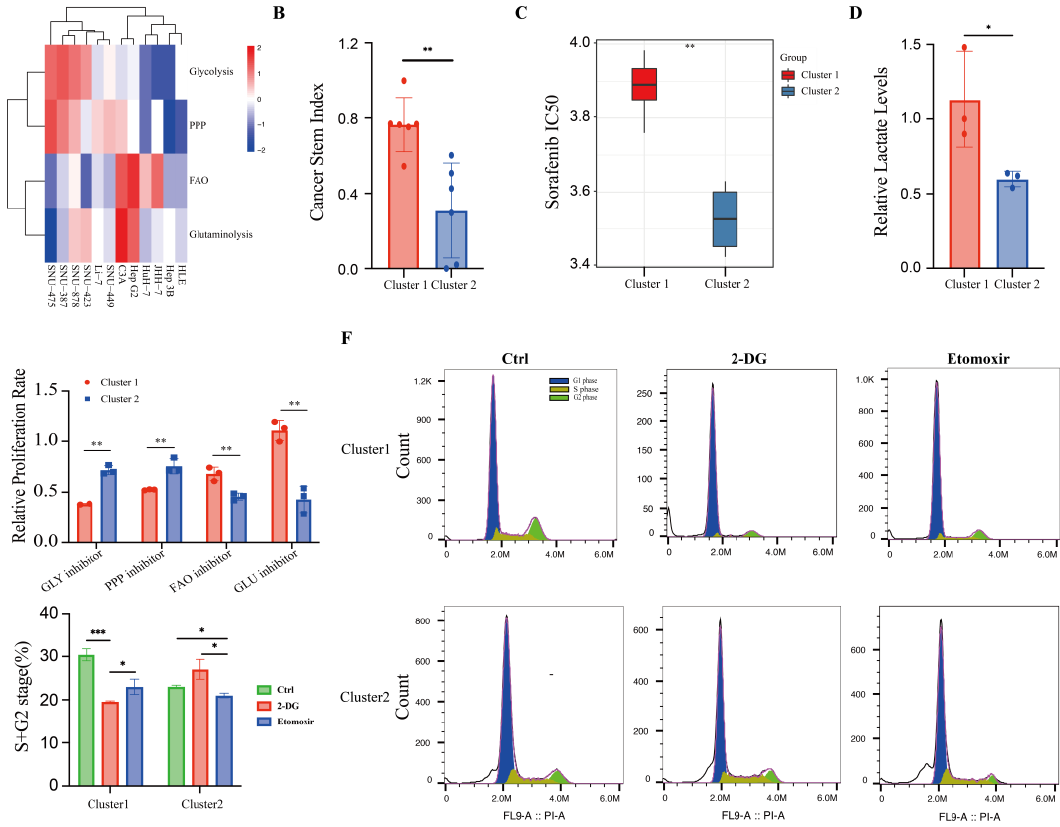
Figure 5. Liver cancer cell lines revealing potential metabolic therapy targets. ( A ) A heatmap showing the metabolic pathway activity levels of 12 common liver cancer cell lines from CCLE. ( B ) Cancer stem indexes of two clusters of liver cancer cells. ( C ) Boxplots of estimated IC50 values for sorafenib. ( D ) Relative lactate production of liver cancer cells. ( E ) Relative proliferation rate upon four metabolic perturbations in HCC cell lines. ( F , G ) Cell cycle progression upon two metabolic perturbations in HCC cell lines: up, SNU-449; down, Hep G2; left, Ctrl; middle, 2-DG; and right, Etomoxir. IC50, half the maximal inhibitory concentration. *, p value < 0.05; **, p value < 0.01; ***, p value < 0.001.